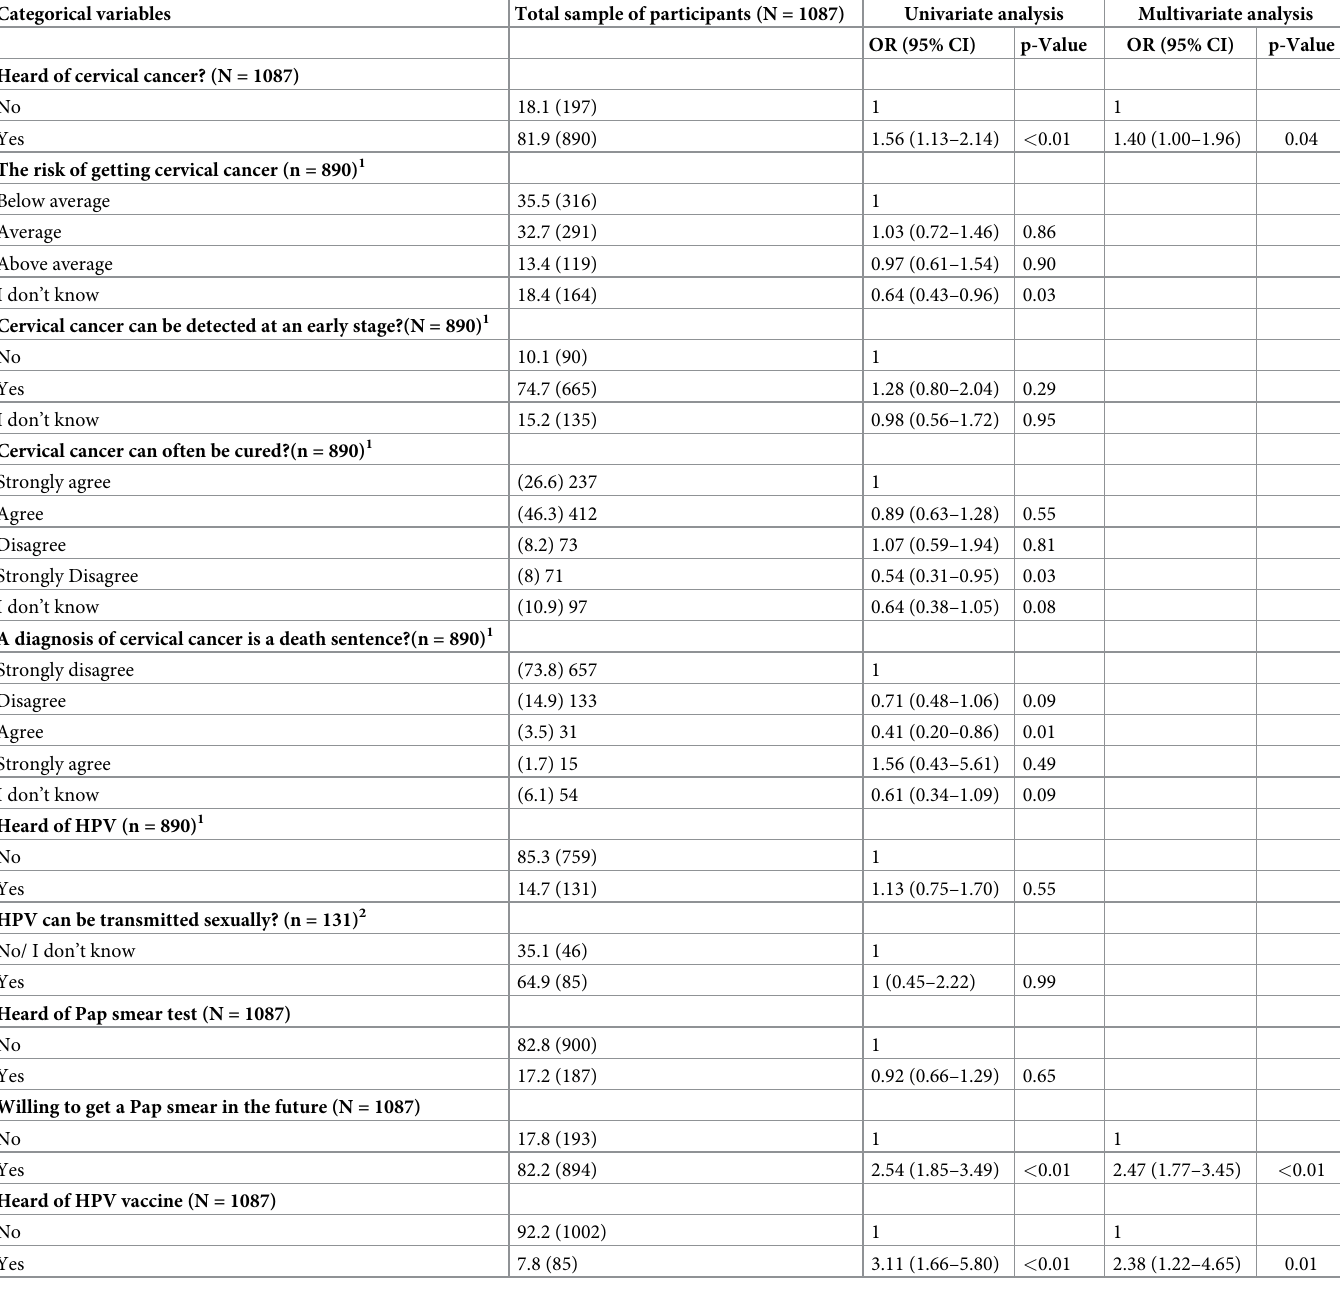
Table 2. Participants’ awareness of cervical cancer, HPV, Pap smear testing and HPV vaccine by willingness to get the HPV vaccine in the future. Morocco between May 2019 and June 2020. Categorical